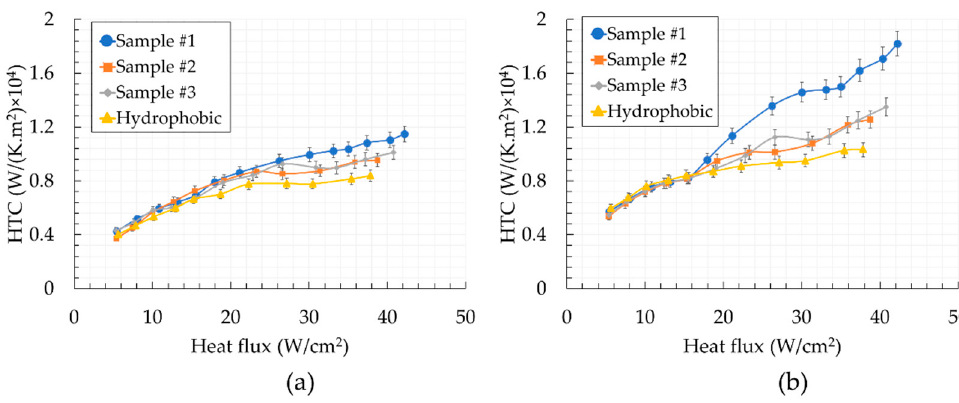
Figure 8. Obtained heat transfer coefficients for mass flux of 120 kg m − 2 s − 1 ( a ) the 1st half of the microchannel ( b ) the 2nd half of the microchannel.